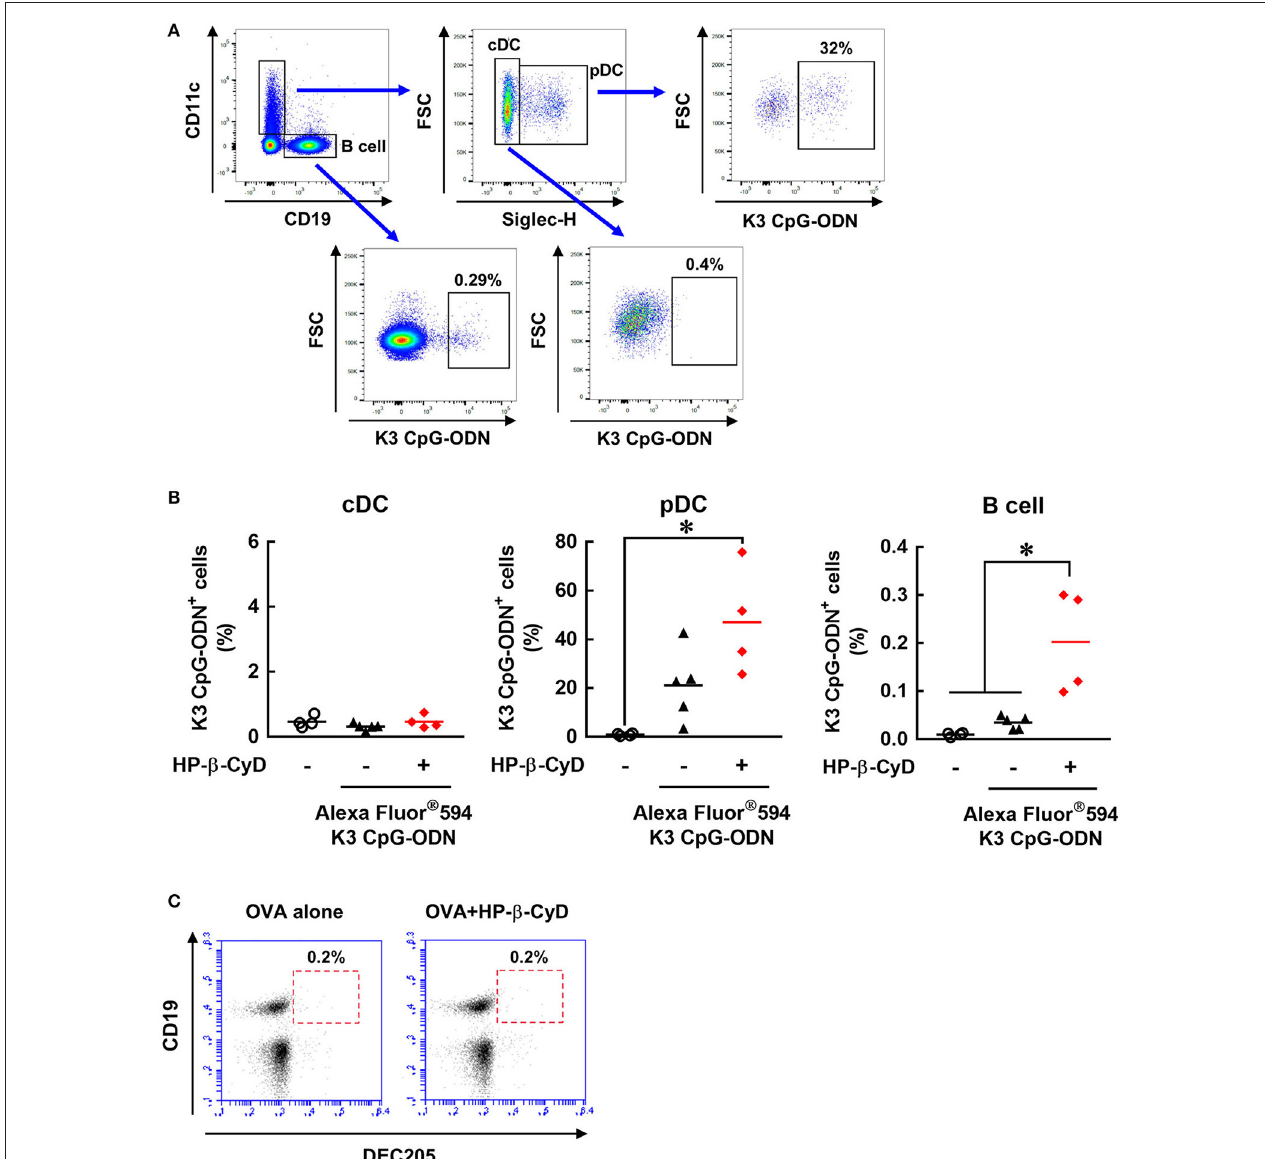
FIGURE 6 | HP- β -CyD enhances the uptake of K3 CpG-ODN by pDCs and B cells in the draining lymph node. (A,B) C57BL/6 mice were injected with OVA solution containing 30% HP- β -CyD and 10 µ g of Alexa Fluor594-labeled K3 CpG-ODN into the base of the tail. After 24h, the draining lymph node was collected, and the uptake of K3 CpG-ODN by CD11c + Siglec-H − cells (cDC), CD11c + Siglec-H + cells (pDC) and CD19 + cells (B cell) was analyzed by flow cytometry. (A) Gating strategy after the exclusion of doublets and dead fluorescent positive cells was shown. (B) Each dot represents an individual mouse ( n = 4 per group in 2 independent experiments). * p < 0.05 (one-way ANOVA with Bonferroni’s multiple comparison test). (C) C57BL/6 mice were inoculated OVA solution containing 30% HP- β -CyD into the base of the tail. After 24h, draining lymph node was collected, and the expression of DEC205 on CD19 + cells was analyzed by flow cytometry. The experiments were performed independently twice, and representative data are